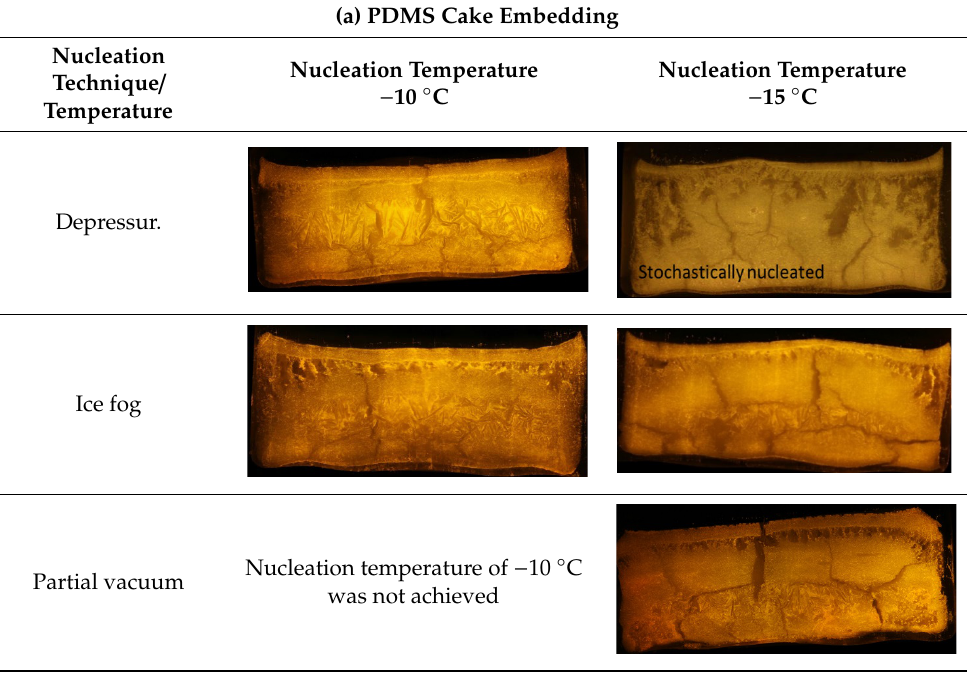
Table 5. Characterization of internal cake structure for enzyme at 2.5 mg / mL lyophilized in 50 cc vials depending on nucleation technique by ( a ) PDMS cake embedding and ( b ) µ CT. ( a ) Samples from initial lyophilization cycle compared to stochastically nucleated sample. ( b ) Samples obtained by aggressive and conservative lyophilization conditions. The nucleation temperatures are indicated per method.